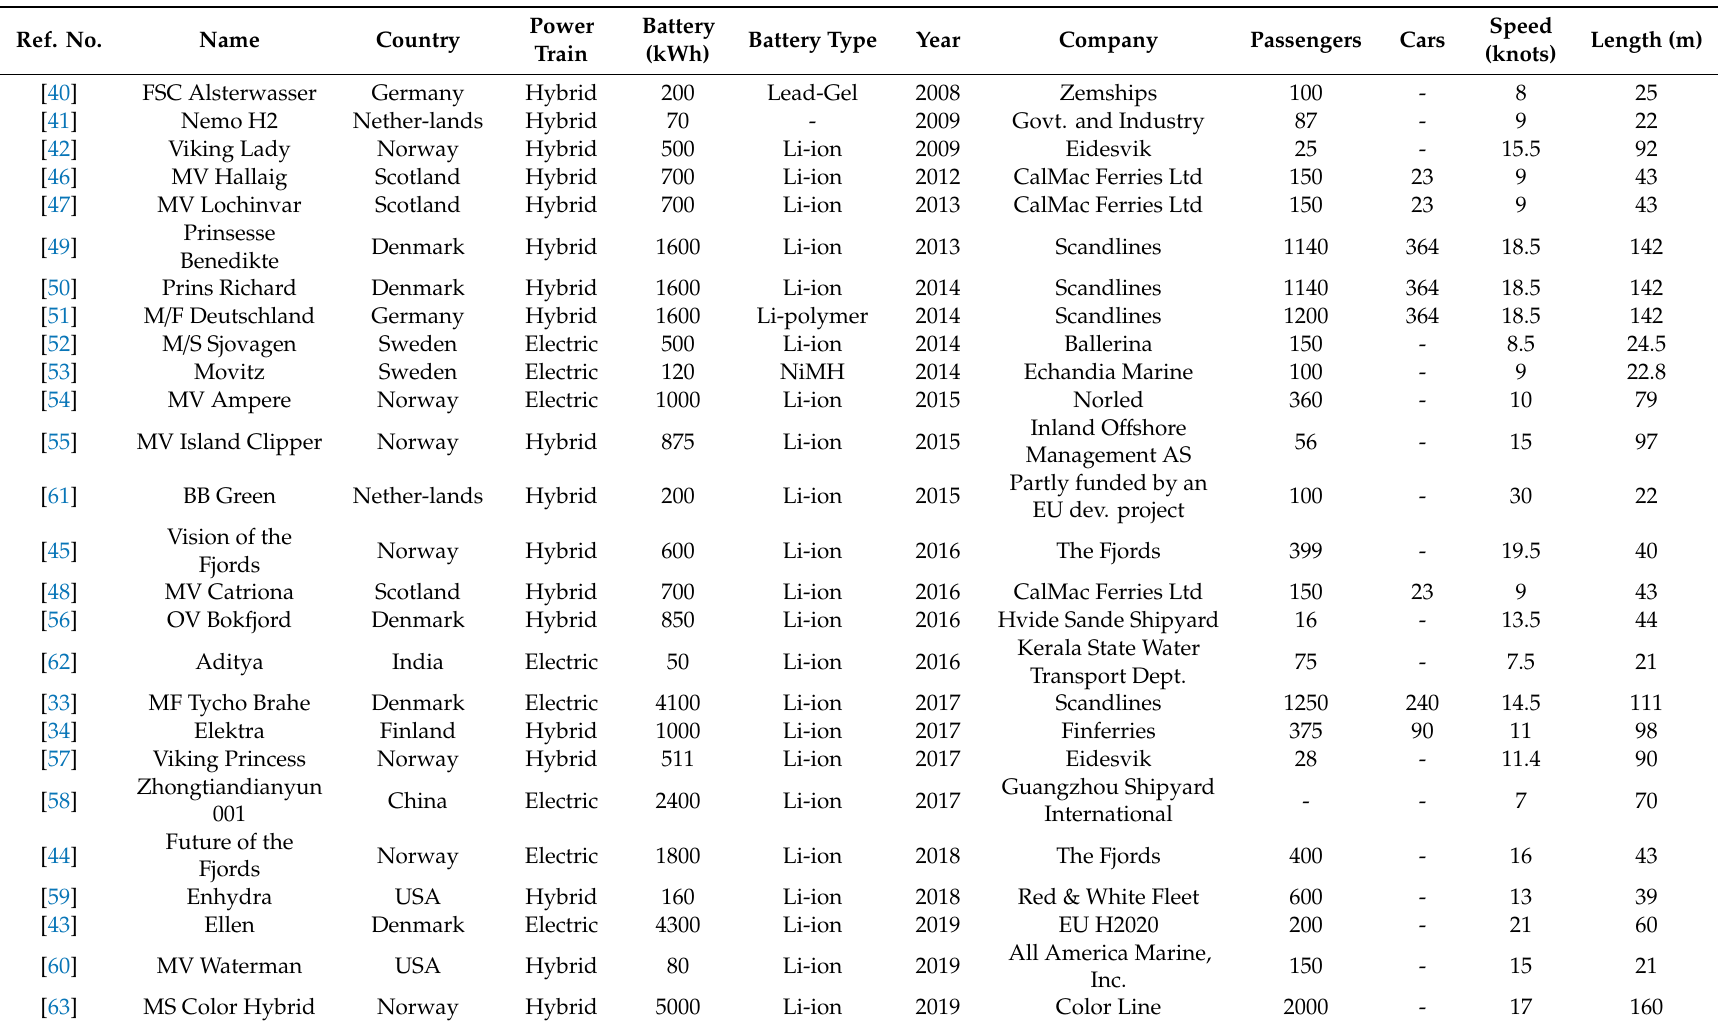
Table 2. Vessel study for battery technology towards electrification.